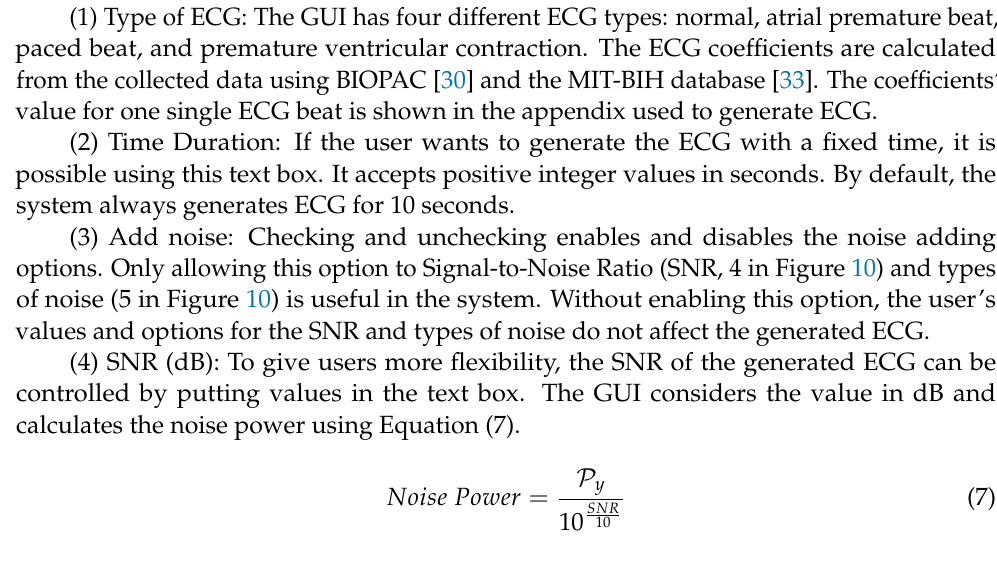
Figure 10. Graphical user interface for the ECG